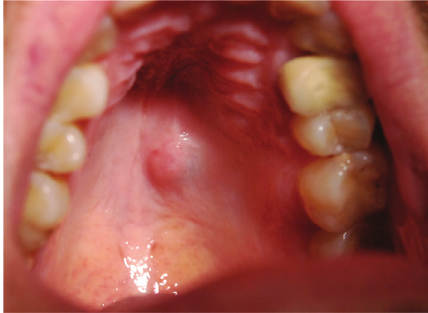
Figure 1: Adenoid cystic carcinoma of the hard palate. years. The mean age of the patients with benign MSGTs was lower (48.3 years) than of those with malignant MSGTs (51.3 years).